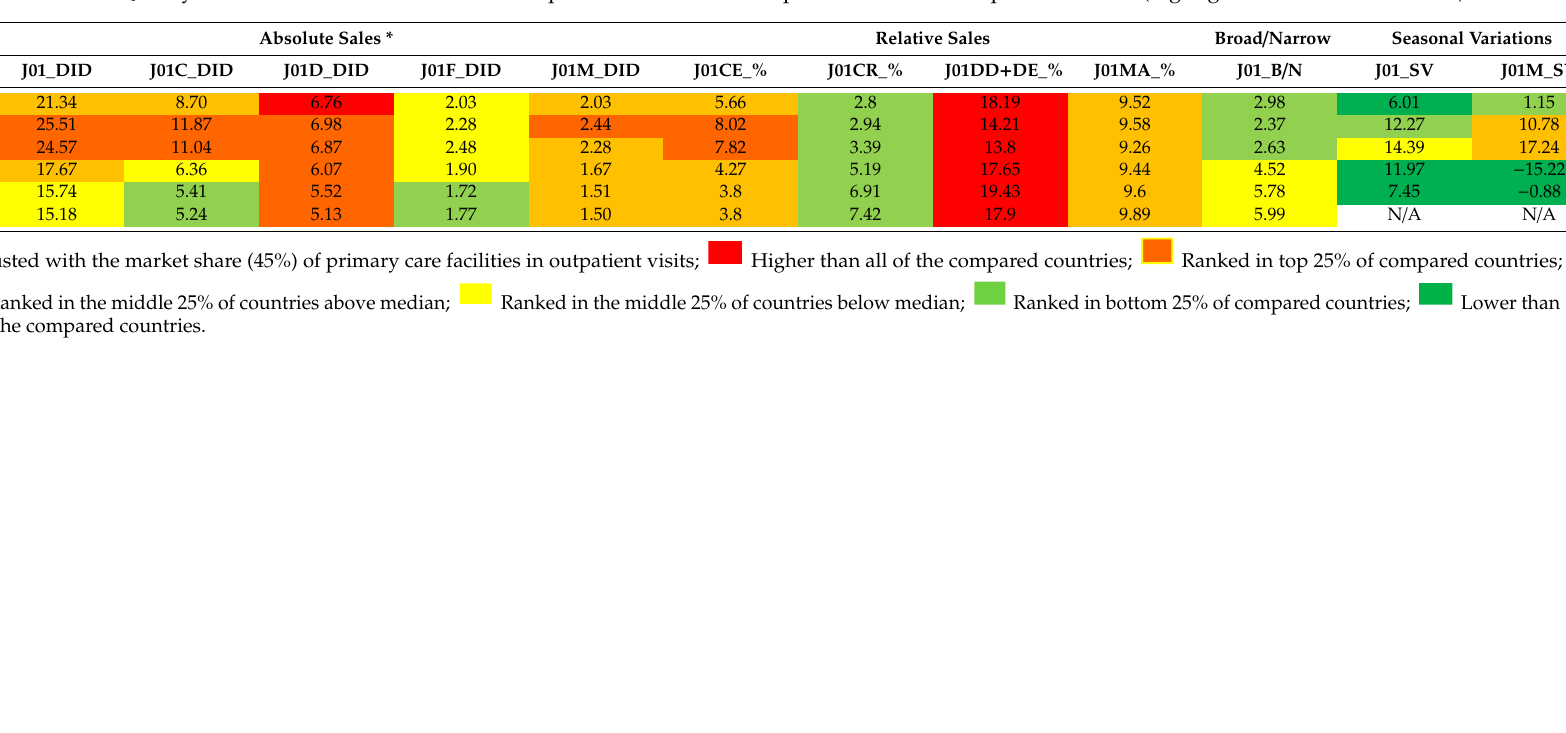
Table 3. Quality indicators for antibiotic sales in outpatient in Hubei in comparison with 31 European countries (highlighted in different colours).